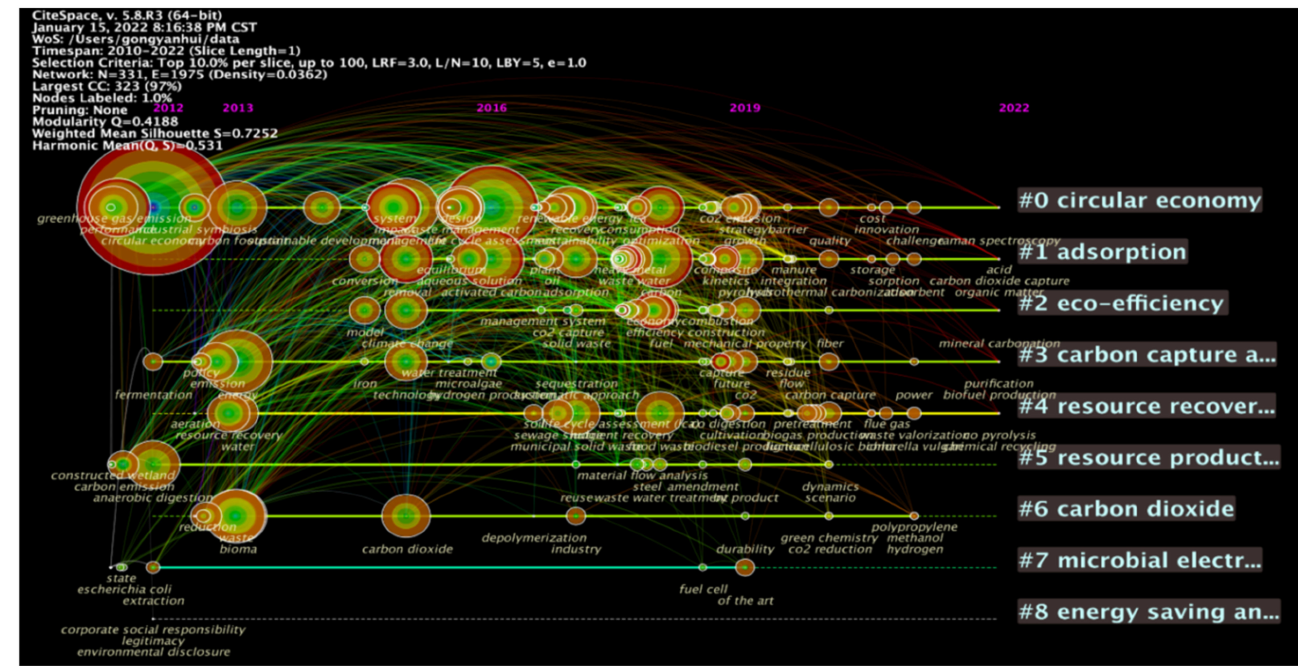
Figure 10. Timeline map of research